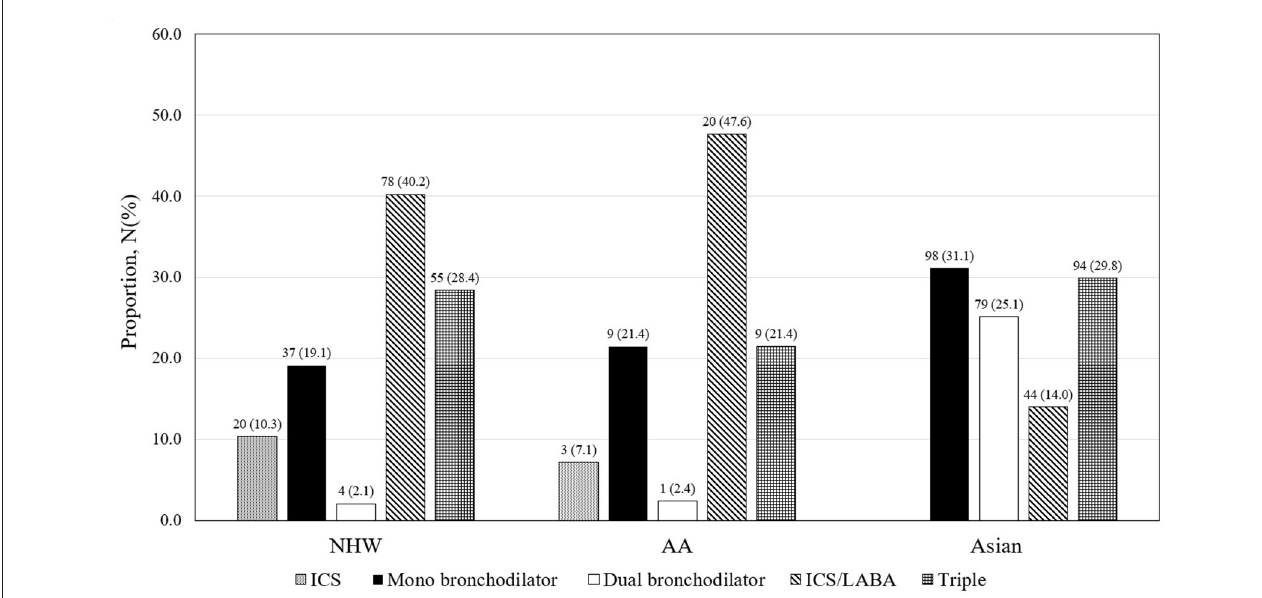
FIGURE 2 | Inhaler prescription status in ACO of COPDGene and KOCOSS. AA, African American; ICS, inhaled corticosteroid; LABA, long-acting β 2 receptor agonist; NHW, non-Hispanic white.